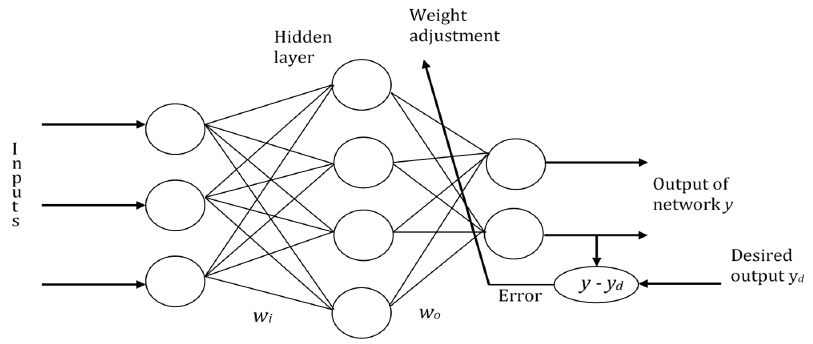
Figure 2. Feedforward neural network with one hidden layer [14].